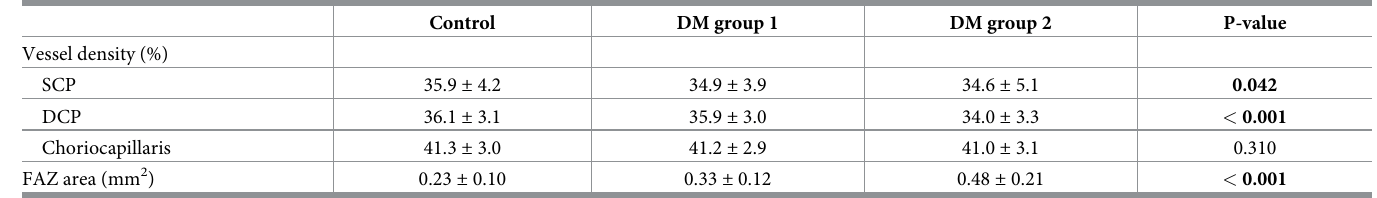
Table 2. Optical coherence tomography angiography parameters in each